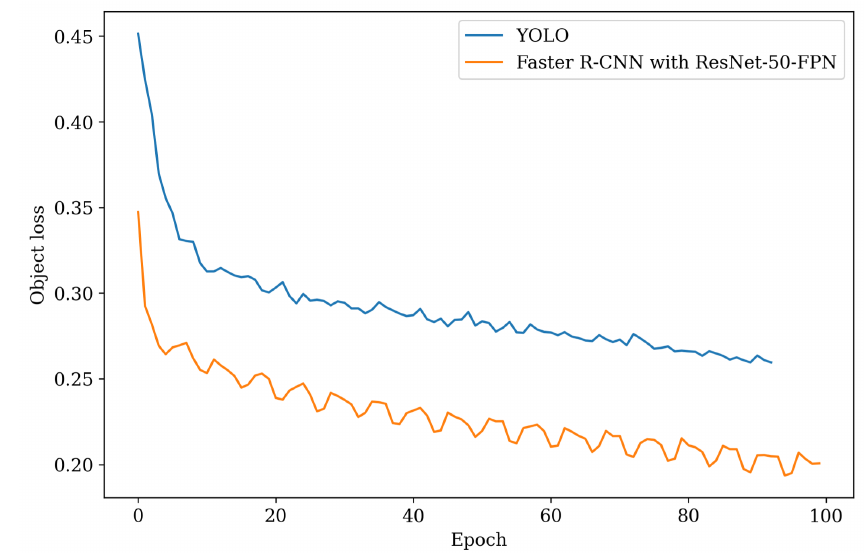
Figure 10. Object loss for YOLO and Faster R-CNN with